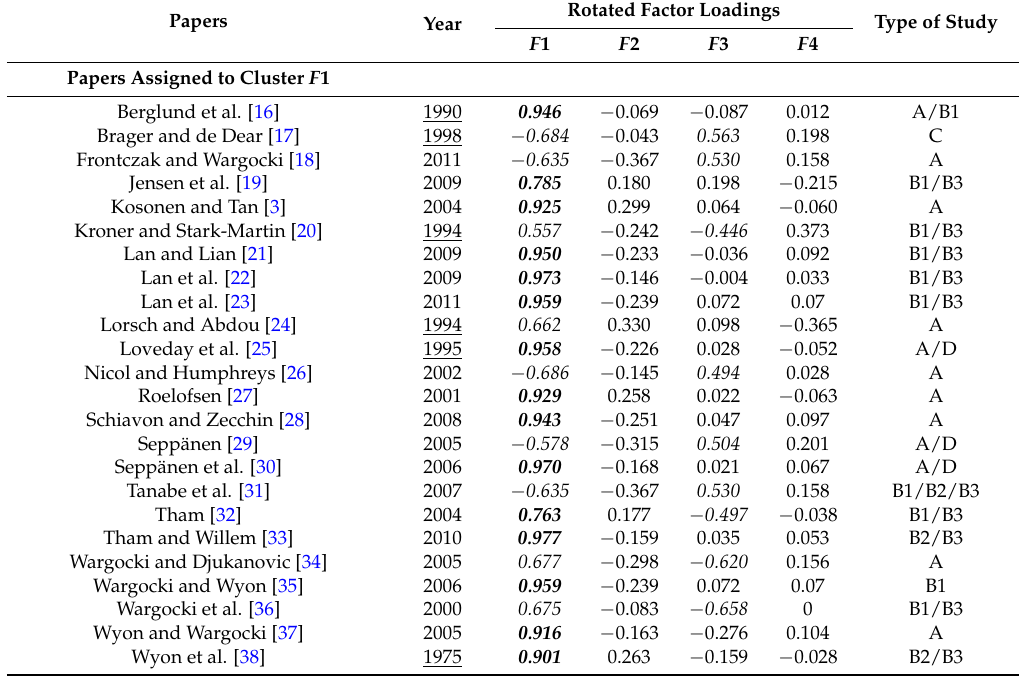
Table 2. Rotated factor loadings of the core set of papers grouped by cluster: the loadings with absolute value larger than 0.4 are in italics, those larger than 0.7 are in bold. The publication year is underlined if prior than 2000. Regarding the type of study: “A” indicates conceptual and theoretical studies, “B1”, “B2”, and “B3” are experimental studies performed, respectively, in the field, in the laboratory, and through surveys, “C” is a literature review, and “D” are simulation